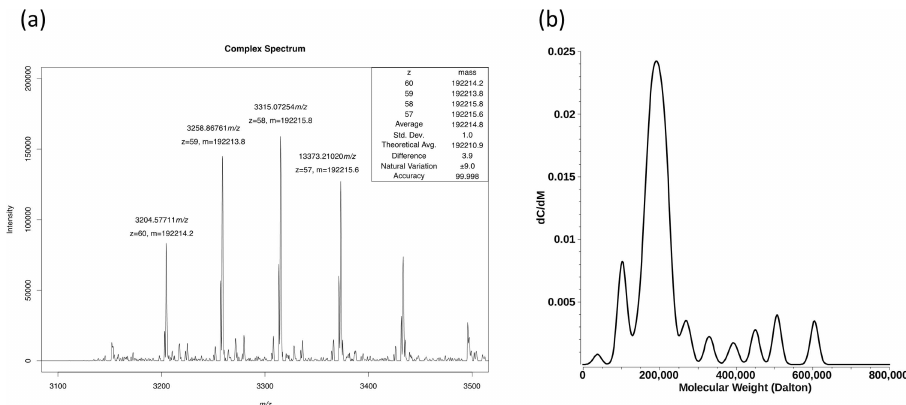
Fig 4. Full-length δ formsexclusivepentamers. (a) Mass spectrometry confirmsthe predominanceof the homo-pentamericcomplex.The experimental mass of the intact complexis 192214.8 ± 1Da andis almost exactlythe mass expectedfor a homo-pentamer. There is no indicationin the mass spectrumof the existenceof an alternativestoichiometry, includingmonomer. Notethat dueto the naturalvariancein isotopiccomposition the averagemass of a proteincomplexof this size is inherentlyuncertain. The sum of the uncertaintiesof the relativeatomicmassesfor this composition resultsin an estimate of the naturalvariationof approximately ± 9Da, indicatingthat the observeddifferenceof approximately 4 Da is wellwithinthe rangeexpected.(b) Molar mass analysisby analyticalultracentrifugation.The integrated molar mass of the majorpeakis consistentwith a pentameric species.Highermolecular weightspeciesare alsovisible,but are presentat lower concentration. Molecular species > 800,000Da are not shownfor clarity.Minor peaksmay explainedby modelinginaccuracies